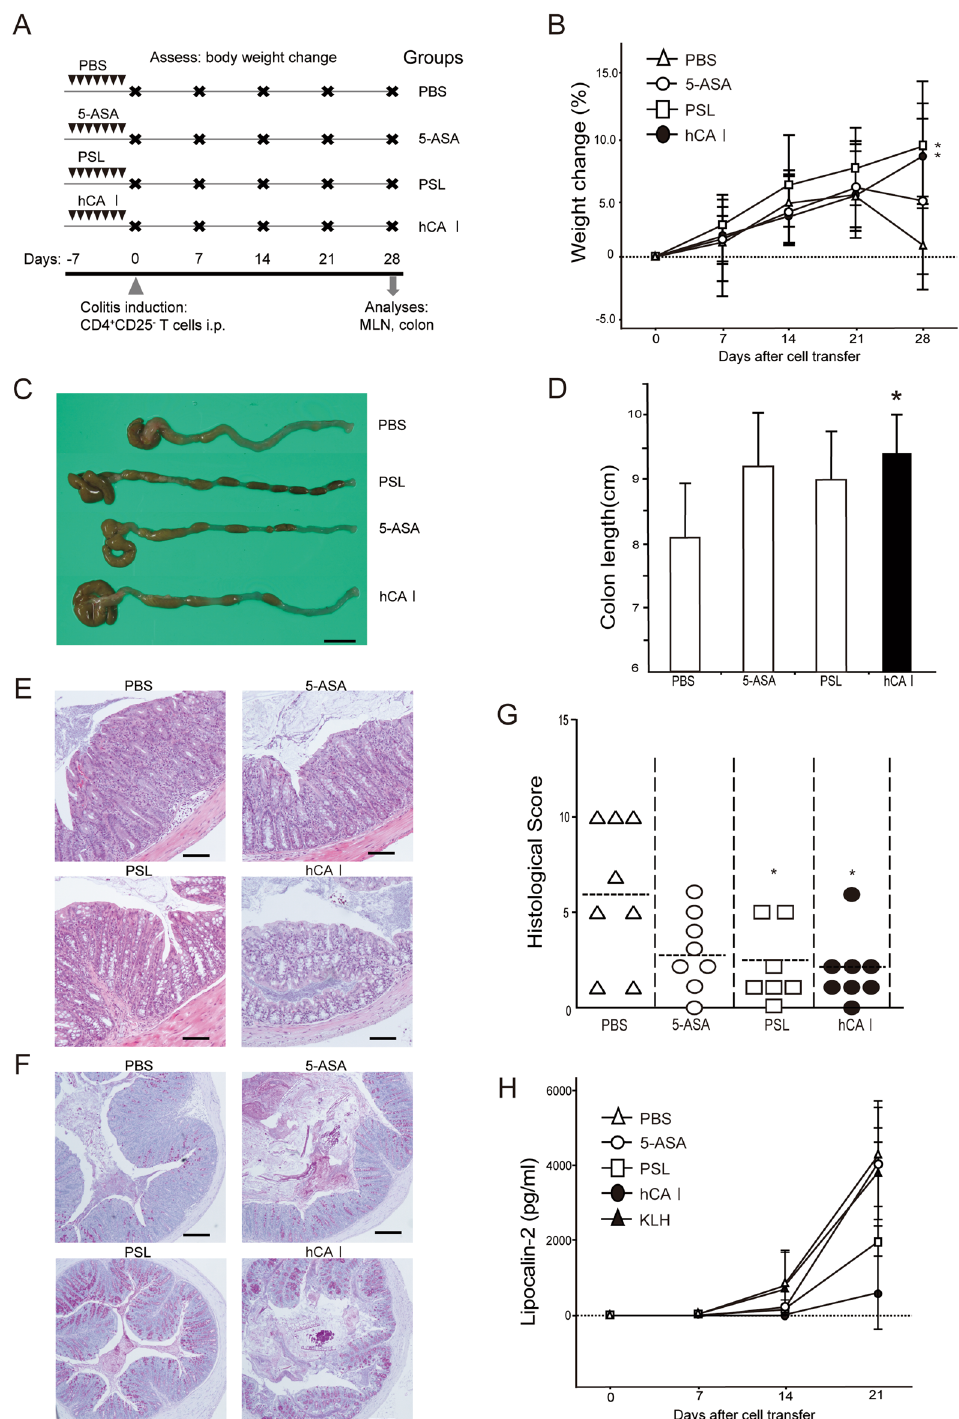
Figure 5. Experimental comparison of therapeutic effects of hCA I with pilot drugs. ( A ) Experimental protocol. Groups: PBS, mesalazine (5-ASA) 100 mg/kg per os (p.o.), prednisolone (PSL) 2 mg/kg p.o., and human CA I (hCA I) 0.3 mg/d p.o. (see “Methods”). ( B ) Relative changes in body weight (%) over time at 0, 7, 14, 21, and 28 days. CD4 + CD25 − T cell (3 × 10 5 ) transfer model mice (n = 8 mice/group) were treated with PBS, 5-ASA (mesalazine), PSL (prednisolone), or hCA I indicated by triangles, white circles, squares, and black circles, respectively. The error bars indicate SD. ( C ) Macroscopic findings of the colon on day 28. Scale: 10 mm. ( D ) Colon lengths in colitic mice on day 28 (n = 8). ( E , F ) Histological analysis of the colon on day 28. PBS- and 5-ASA-treated mice evidenced inflammatory cell infiltration, marked increase in mucosal height (H&E stain; original scale: 100 μm), and severe loss of goblet cells (periodic acid Schiff staining; original scale: 200 μm) magnifications are shown. Oral administration of hCA I and PSL improved these findings. ( G ) Histological scores on day 28. Horizontal bars: median; * P < 0.05 (vs. PBS-treated mice). Data shown are representative of two independent experiments. ( H ) Analysis of the fecal biomarker lipocalin-2. CD4 + CD25 − T cell (3 × 10 5 ) transfer model mice (n = 3 mice/group) were treated with PBS, 5-ASA (mesalazine), PSL (prednisolone), hCA I, or KLH indicated by triangles, white circles, squares, black circles, and black triangles,